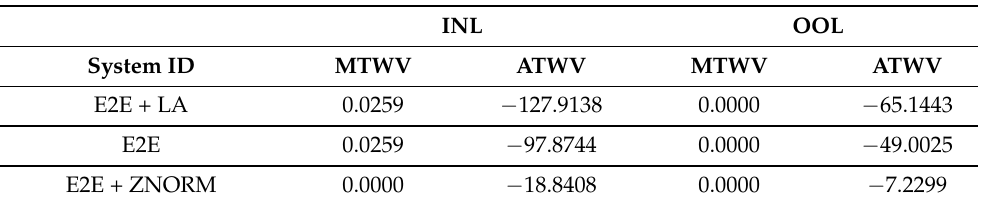
Table 27. System results of the QbE STD task for RTVE test data for in-vocabulary (INV) and out-of-vocabulary (OOV) queries.